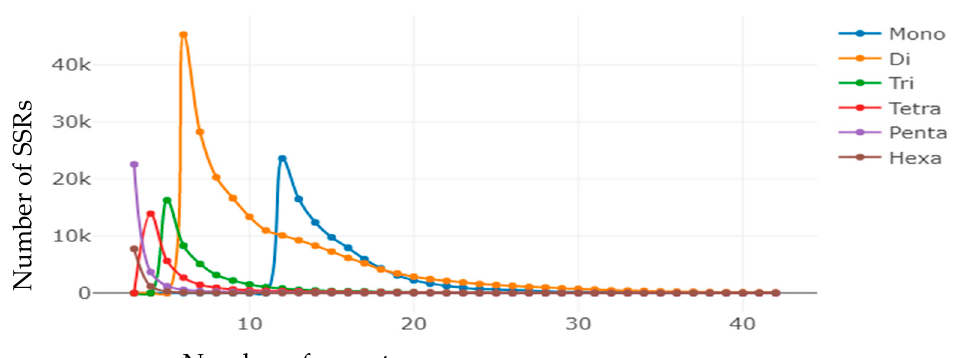
Figure 3. Distribution of SSR repeat number for each SSR type in blackhead seabream.